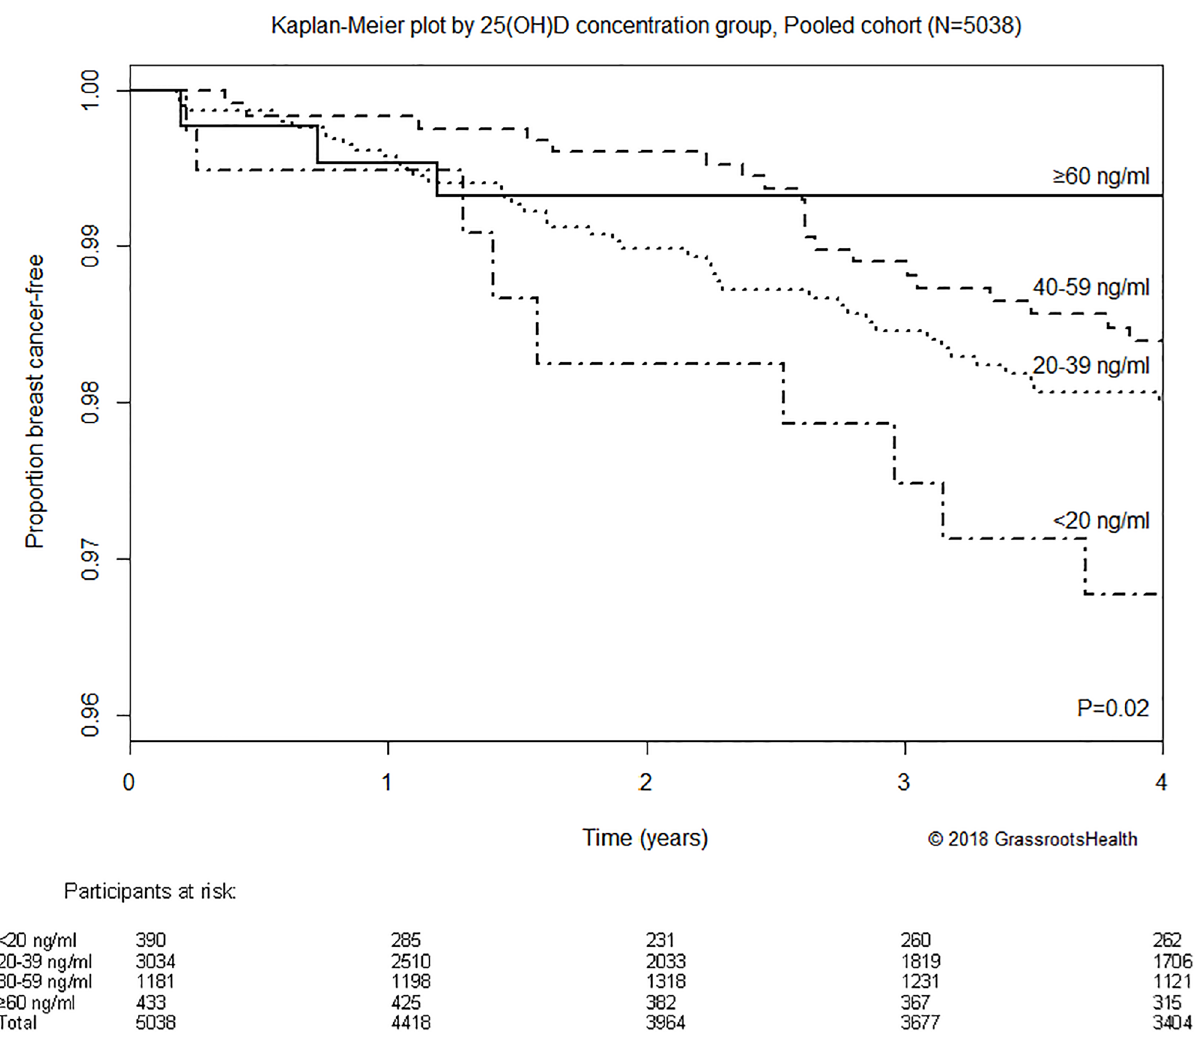
Fig 2. Kaplan-Meier plot comparing the proportion of breast cancer-free participants by 25(OH)D concentration, pooled cohort (N = 5038). Participants were allowed to move between strata of 25(OH)D according to changes in 25(OH)D concentration over the course of the observation periods. Four-year cumulative breast cancer-free proportion was 99.3% among participants with 25(OH)D concentrations (cid:21) 60 ng/ml compared to 96.8% for those with 25(OH)D concentrations < 20 ng/ml (the proportion with breast cancer was 78% lower for (cid:21) 60 ng/ml vs < 20 ng/ml, P = 0.02).